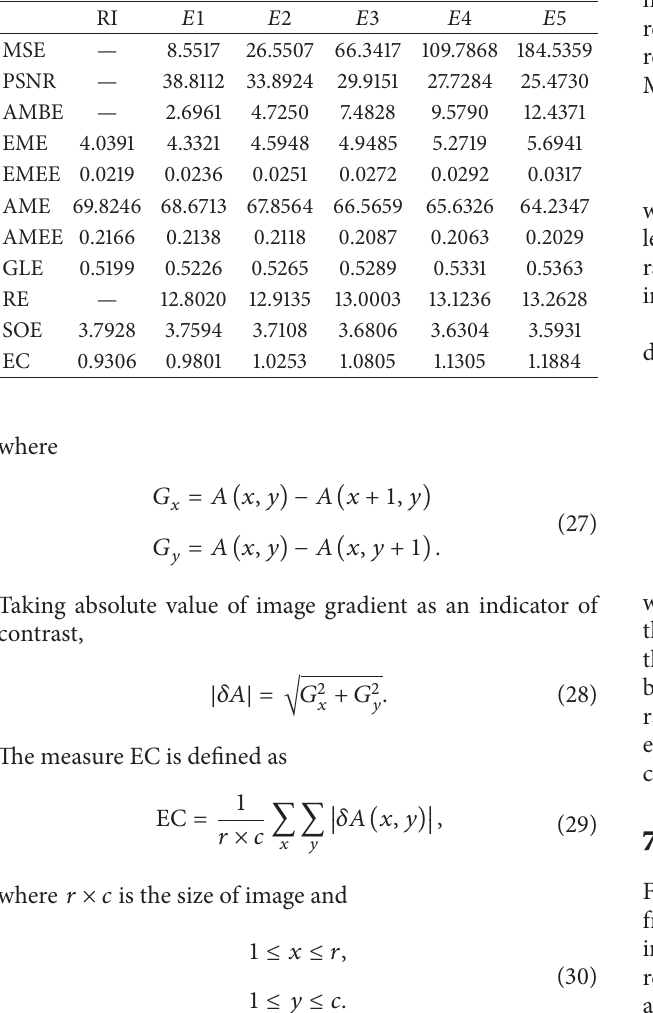
Table 1: Average metrics values for brain cancer